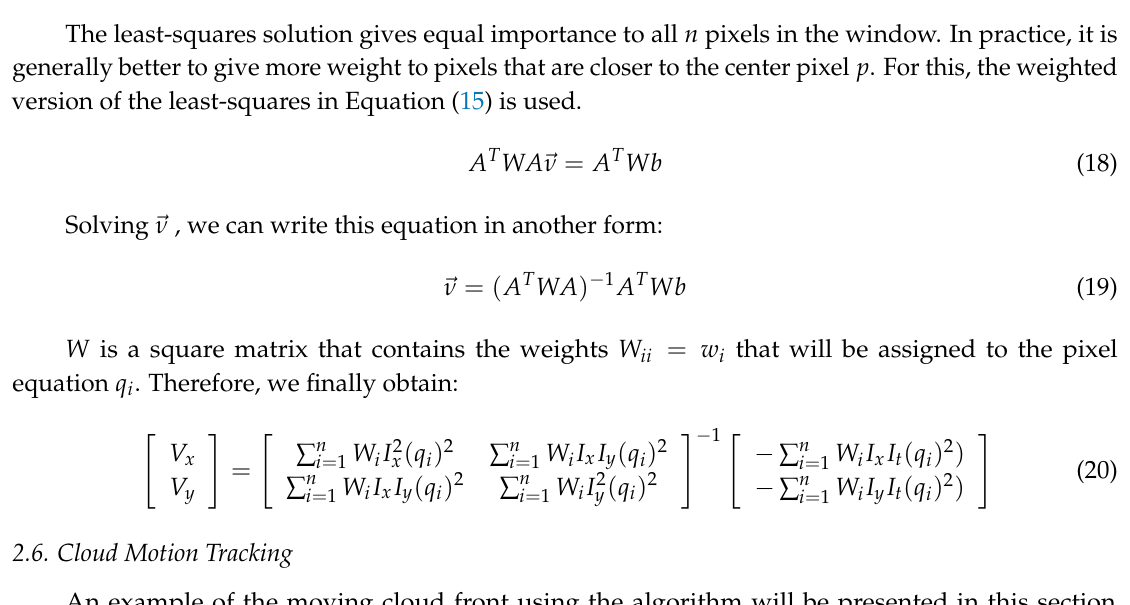
Figure 3a–c correspond to original images and Figure 3d–f are their extracted red channels, respectively. To detect the cloud movement between two consecutive images, we performed the matrix